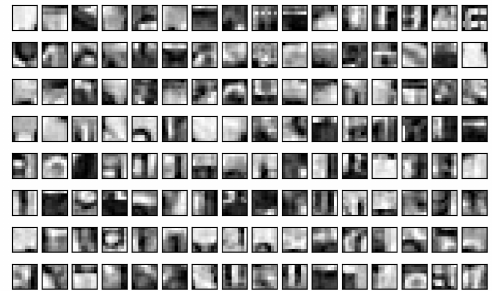
Figure 5. The learned dictionary of the training set by using the K-SVD